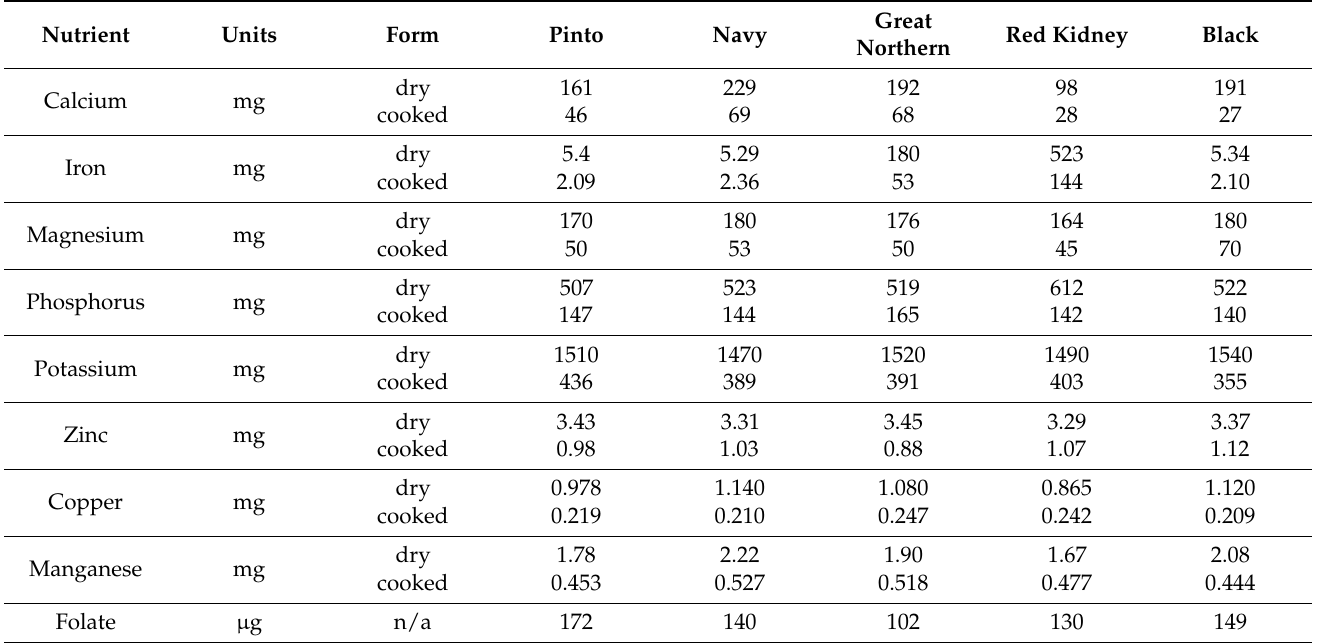
Table 2. Micronutrient composition of common beans in 100 g of edible